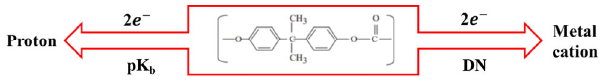
Fig. 4 pK b and DN parameters in ion transfer relationships.